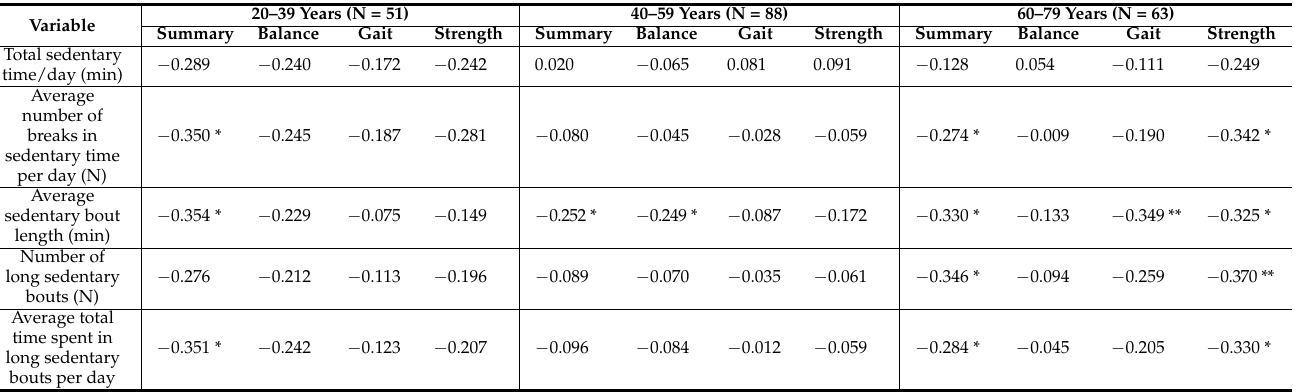
Table 4. Spearman rank-order bivariate correlations between volume and pattern of sedentary behavior and summary and component scores for the Short Physical Performance Battery (SPPB) across age groups of persons with multiple